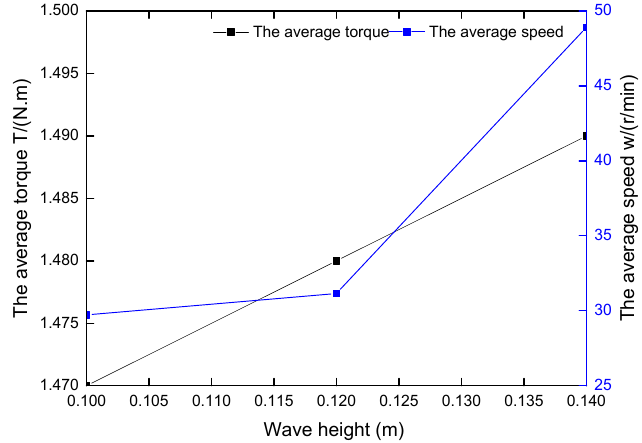
Figure 13. The average torque and rotational speed as a function of wave height with T = 1.26 s.